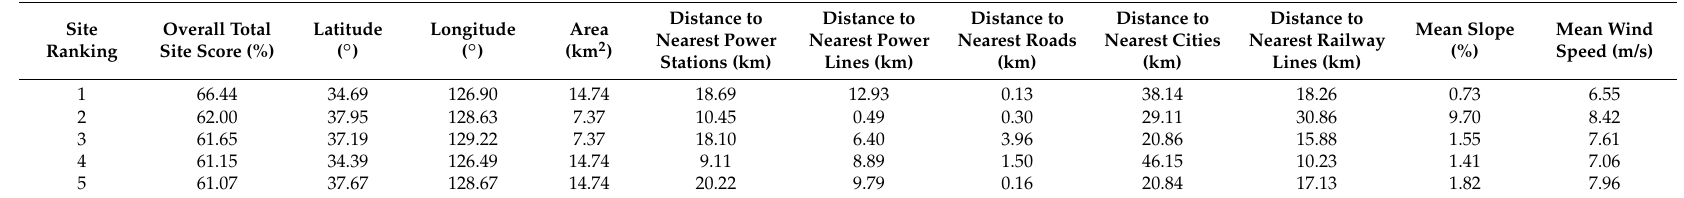
Table 16. Details of Top 5 wind farm sites in South Korea (Scenario 4).